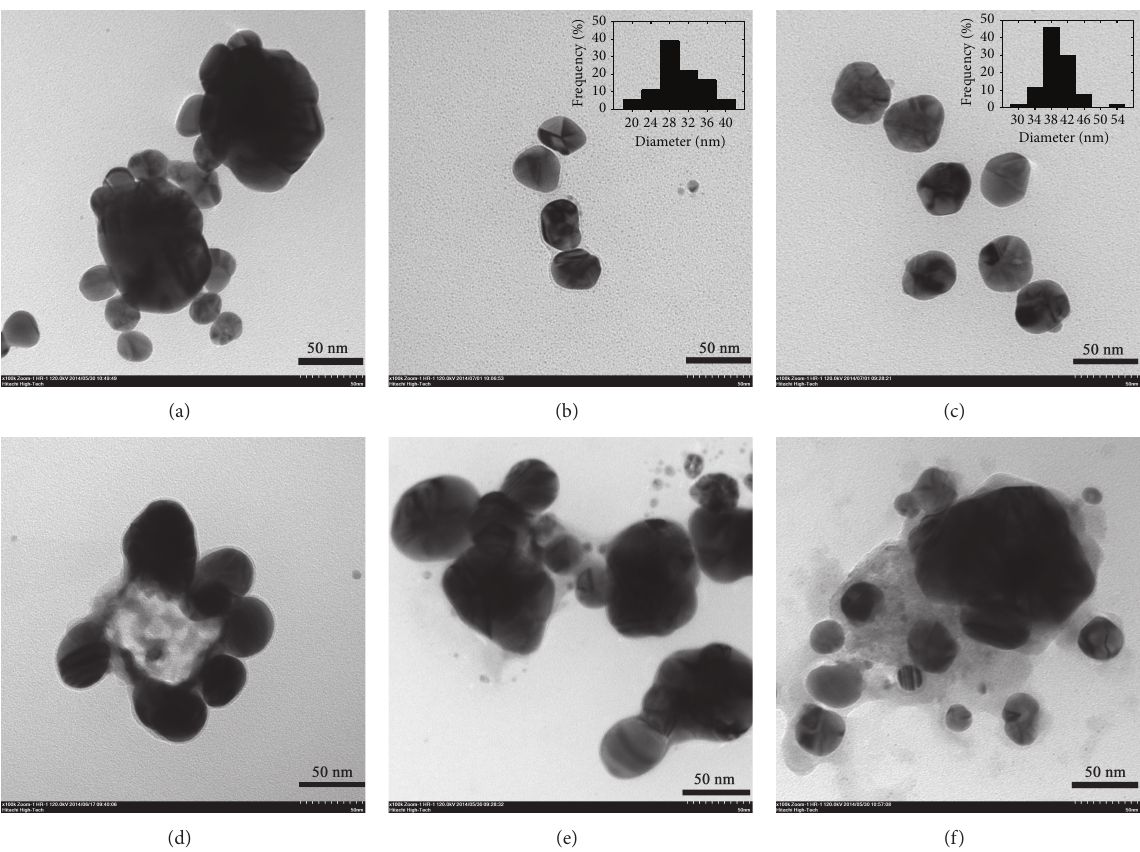
Figure 2: TEM images representing the morphology and dispersion of colloidal AgNPs. Top panel are images of AgNPs prepared in 2% (w/v) PVA solutions at irradiation doses of (a) 20, (b) 40, and (c) 60 kGy. Insets show histograms of size distribution. In lower panels, AgNPs were formed at the irradiation dose of 60kGy in (d) 5% (w/v) SF, (e) 0.5% (w/v) PVA, and (f) 1.0% (w/v) PVA solutions.